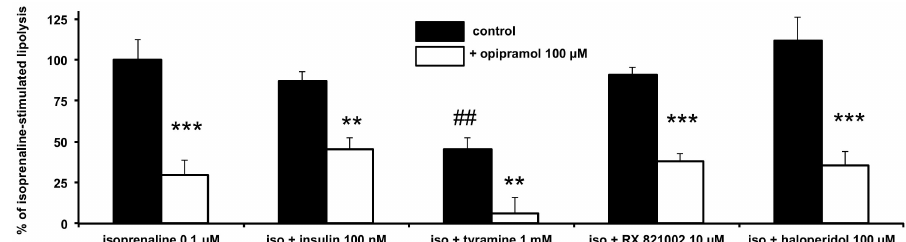
Figure 4. Combination of opipramol with insulin, tyramine, RX 821002, or haloperidol on isoprenaline-induced lipolysis in human adipocytes. Human subcutaneous fat cells were incubated for 90 min with 0.1 µ M isoprenaline (iso) alone or in combination with the following agents: 0.1 µ M insulin, 1 mM, tyramine, 10 µ M RX 821002, 100 µ M haloperidol. Results are expressed as percentage of 0.1 µ M isoprenaline-induced glycerol release, which averaged 0.91 ± 0.11 µ mol glycerol / 100 mg lipid / 90 min ( n = 6). In parallel, adipocyte suspensions were also incubated in the presence of 100 µ M opipramol. Mean ± SEM of six cases. The lipolysis was significantly lower in the presence of opipramol (open columns) than in respective control (control, black columns) at **: p < 0.01, ***: p < 0.001. Tyramine inhibited isoprenaline stimulation at ##: p < 0.01, whereas other agents were ine ffi